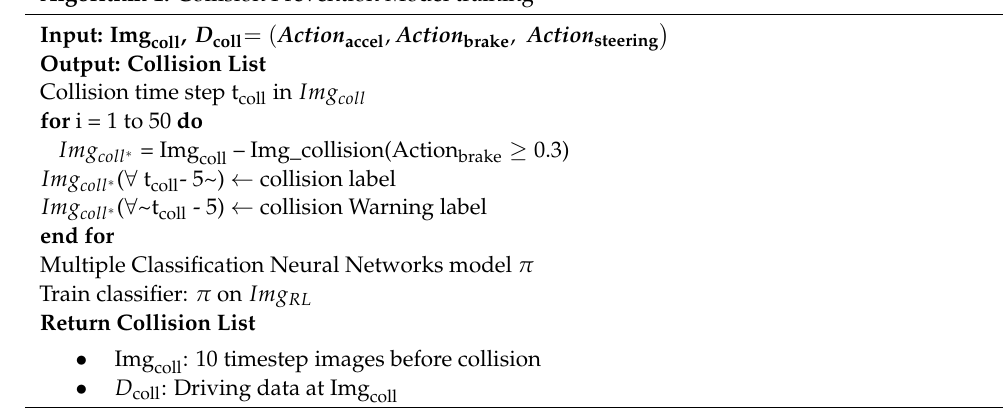
Algorithm 1. Collision Prevention Model